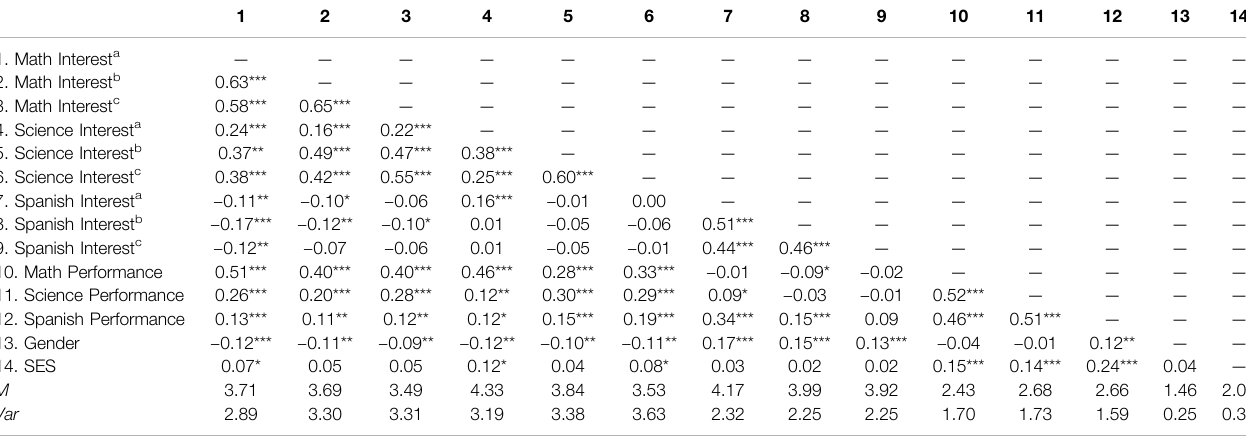
TABLE 2 | Correlations, means, and variances for the Spanish